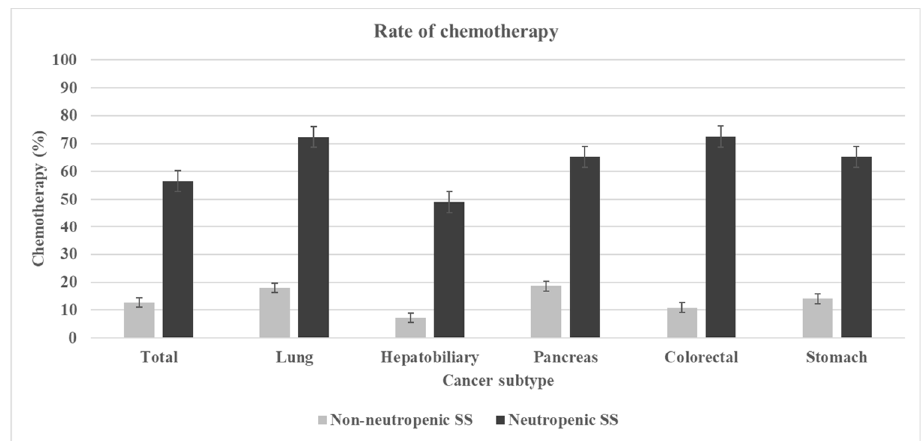
Figure 3. Comparison of rate of chemotherapy within preceding 30 days in each group according to cancer subtype. SS, septic shock.